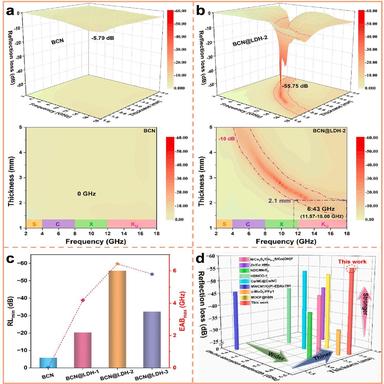
3D representations of RL and corresponding 2D maps for (a) BCN, and (b) BCN@LDH-2. (c) Frequency dependence of the real permittivity, imaginary permittivity, and dielectric loss tangent for BCN@LDH-2. (f) RLMin, thickness and EABMax values of BCN@LDH-2 in this work with other absorbers reported recently. (g) The 2D reflection loss and impedance matching of BCN@LDH-2. (d) The mechanisms of EMW absorption in BCN@LDH-2.